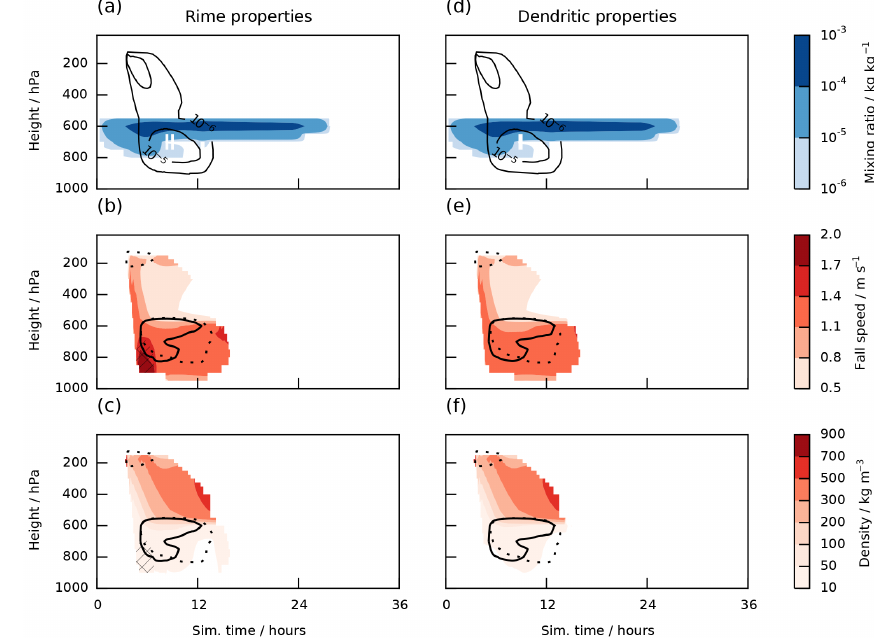
Figure 12. Time series of the vertical profiles of the particle properties for the seeder–feeder simulation described in the text. Panels (a) – (c) and (d) – (f) show results for the simulations with and without taking the change in particle properties due to riming into account, respectively. Panels (a) and (d) show the water mixing ratios (colors for liquid, contours for ice), (b) and (e) show ice particle fall speeds, and (c) and (f) show ice particle density. In panels (b) , (c) , (d) and (f) , the solid and dotted lines show regions of significant ( > 10 − 9 kgkg − 1 s − 1 ) riming and depositional growth, respectively. Hatches mark areas where F r > 0 . 5, i.e., where particles are dominated by rimed